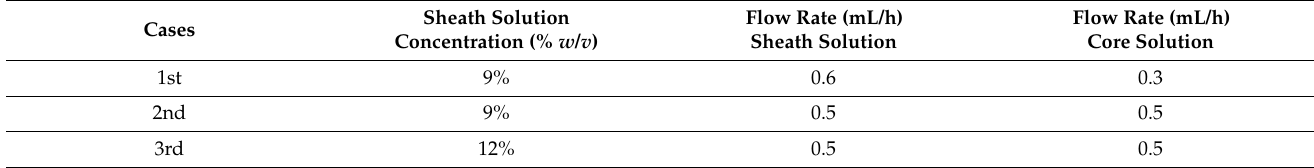
Table 2. Cases examined for the construction of PCM electrospun fiber matrices.